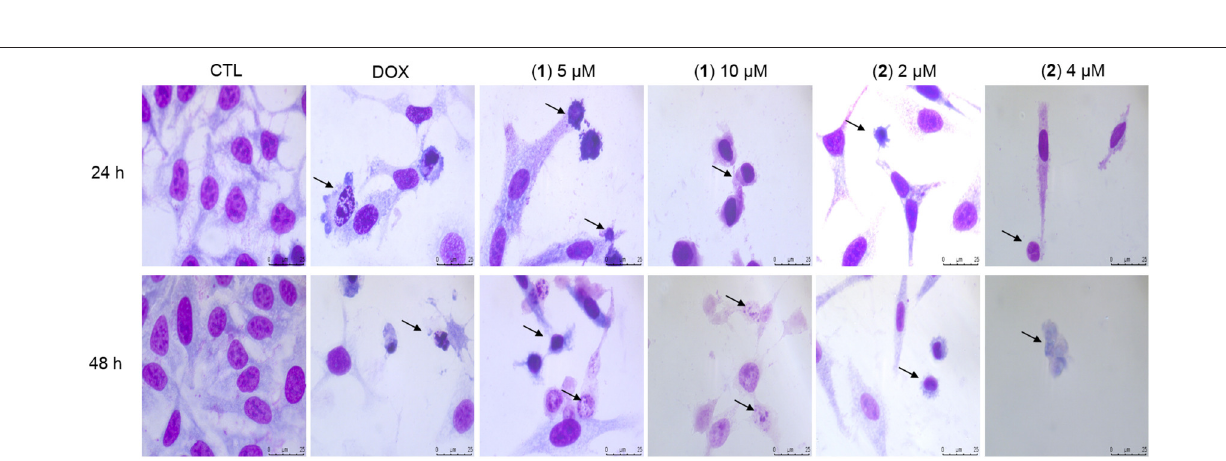
Frontiers in Oncology |